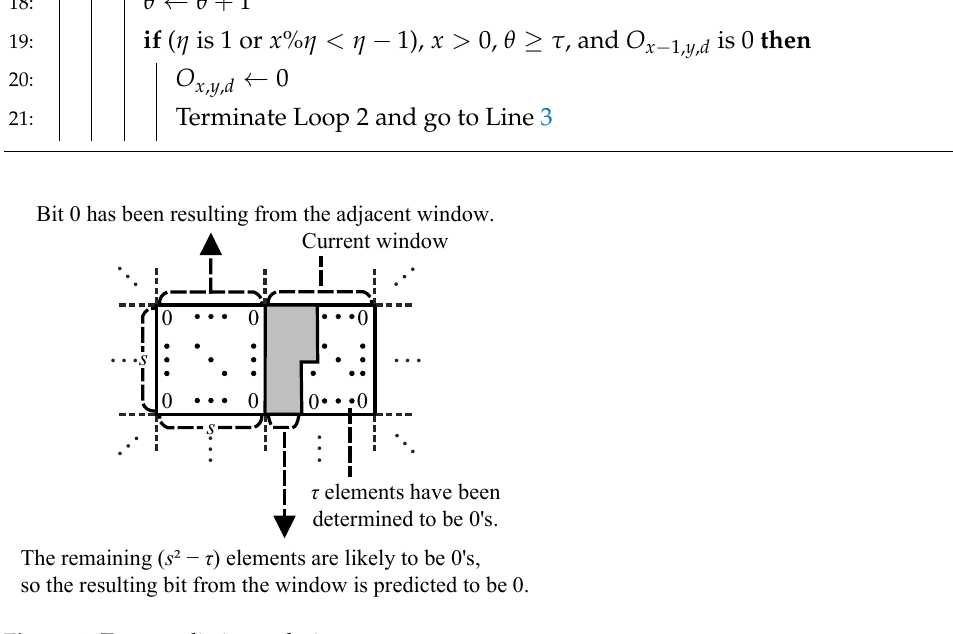
Figure 4. Zero prediction